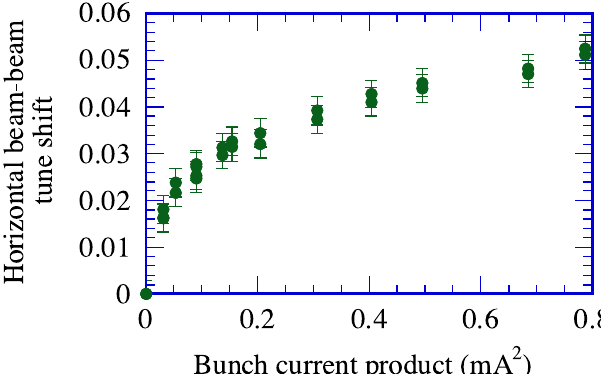
FIG. 9. (Color) Horizontal coherent beam-beam tune shift as a function of the product of bunch currents.